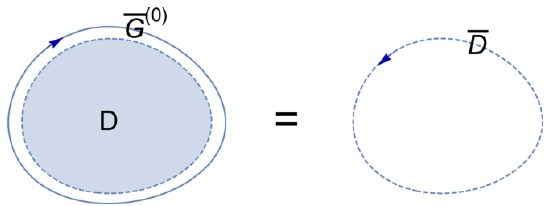
Figure 4 . The picture represents eq. (4.11). The deformation operator is integrated over the region R (the blue region). The clockwise contour of integral R d (cid:22) w of (cid:22) G (0) is slightly outside region R, while the counterclockwise contour of integral R dw of (cid:22) D is along the boundary of